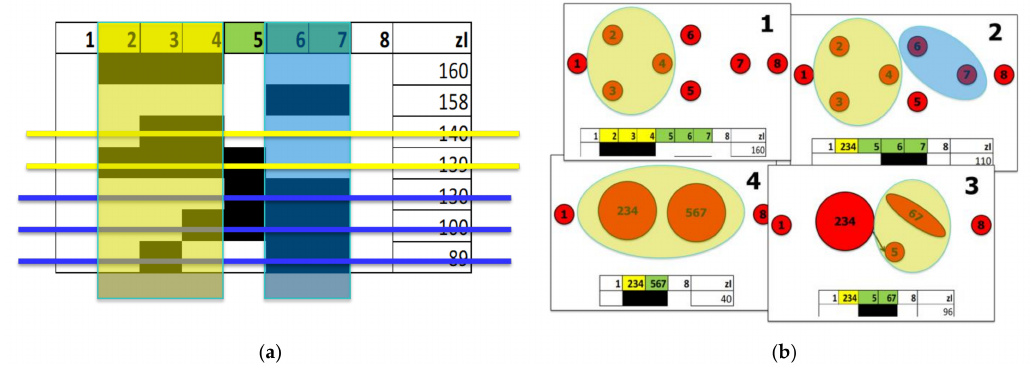
Figure A2. Example of the iterated sieving algorithm. ( a ) Given the list of subsets of the system, sorted by descending zI , it is possible to eliminate all candidate RSs that include or are included in stronger RSs candidates. This elimination is performed starting from the highest value subsets: in the end only strong, disjoint, or only partially overlapping subsets remain. ( b ) The iteration of the procedure, supposing to merge at each step the single strongest RS candidate into a single variable. At each step, the zI indices of the new subsets are calculated, until the index value of the most relevant set detected falls below the threshold zI_theta (the fifth step, not shown in the figure).